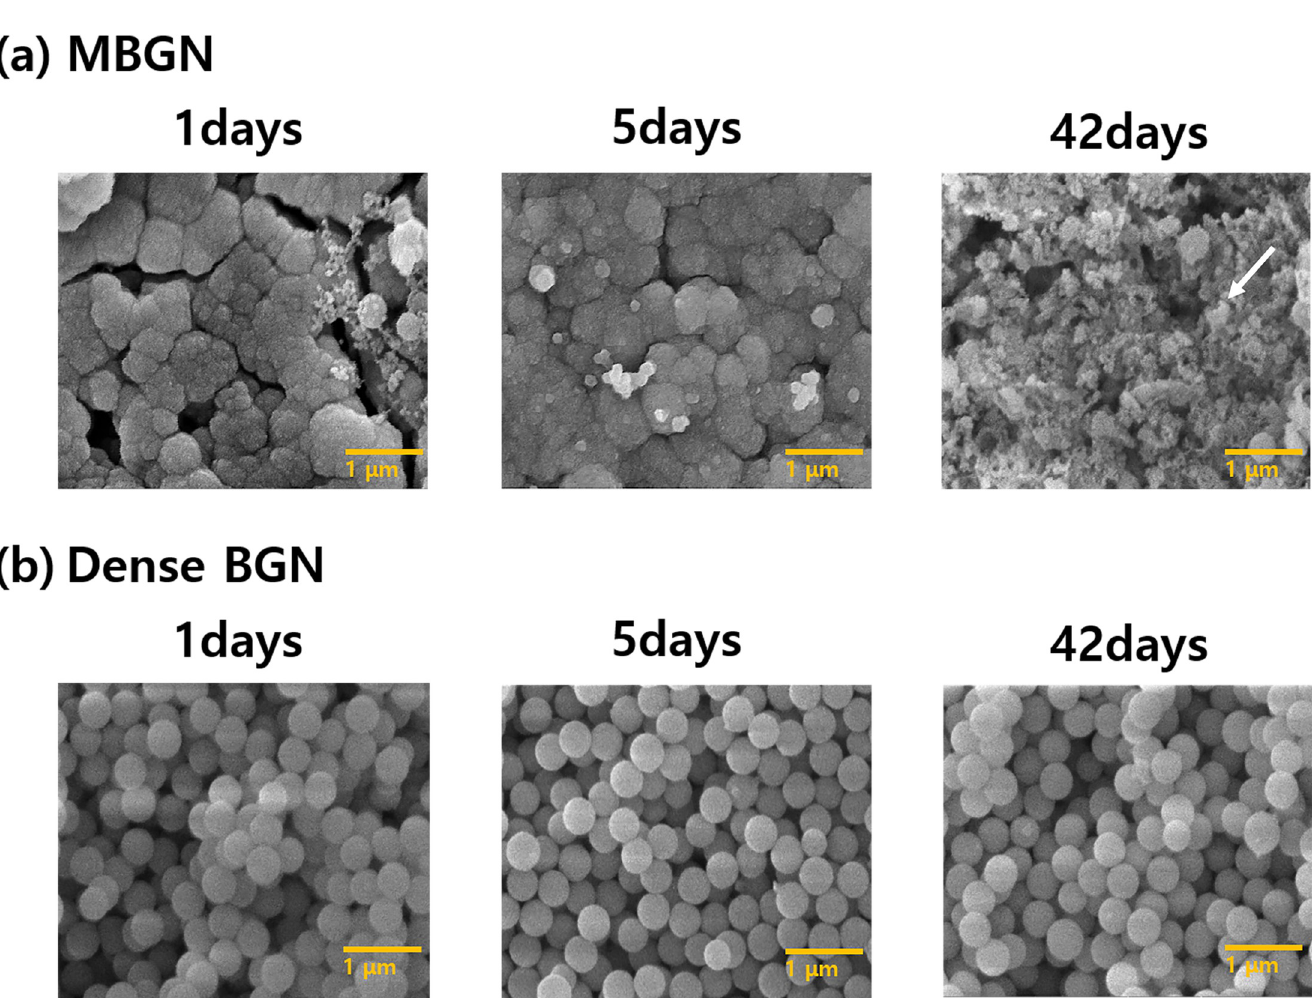
Fig 10. FESEM images of (a) MBGN and (b) Dense BGN tablet at 1, 5, 42 days after soaking in simulated body fluid (SBF) solution.